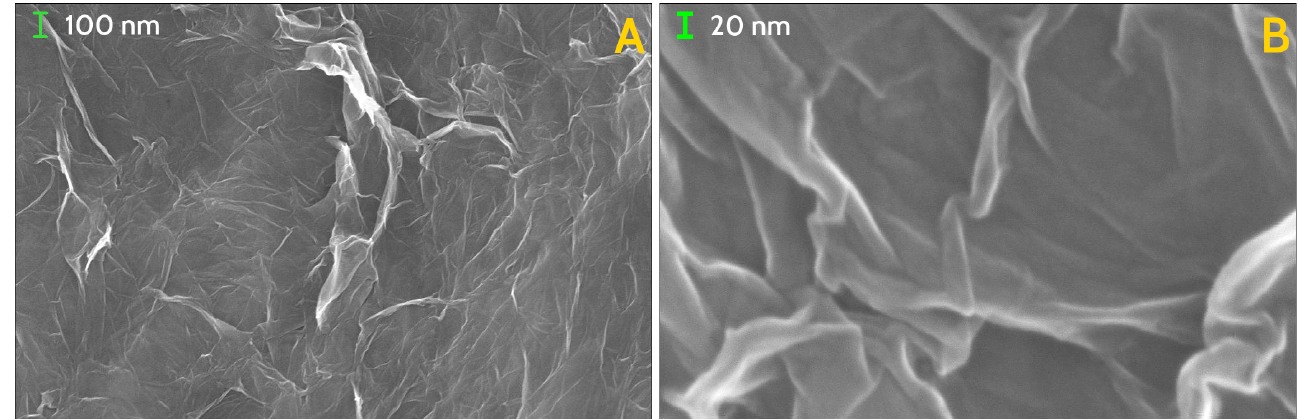
Figure 3. SEM images of the investigated GS, at scale of magnification of 100,000 × ( A ) and 500,000 × ( B ). Lamellar structures forming sharp angles are organised in closed paths at every scale of magnification, down to tens of nanometers.